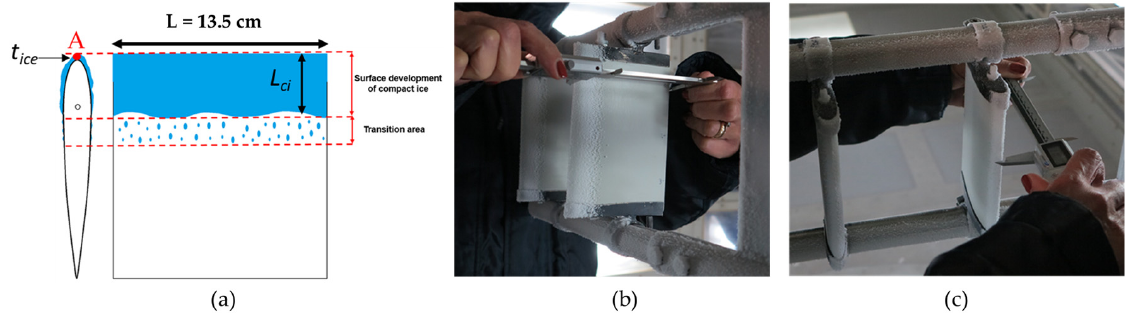
Figure 13. Schematic drawing of the accreted ice shape. With an angle of attack equal to zero, A represents the stagnation point ( a ). Measurement of the samples’ chord length after each test ( b , c ).